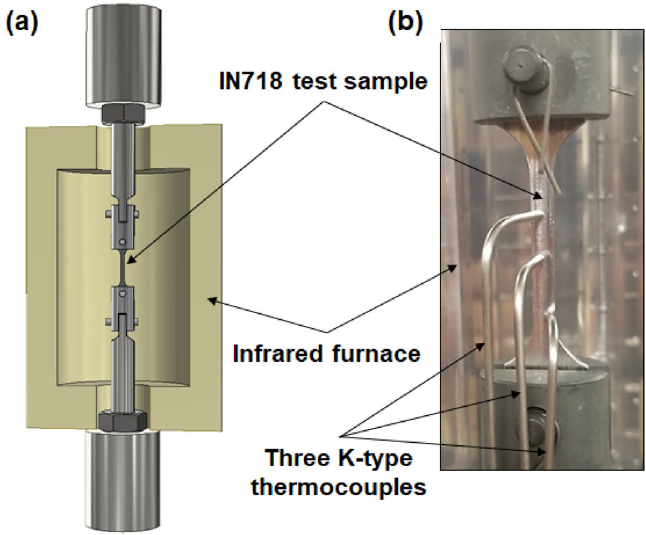
Figure 3. ( a ) Schematic illustration of the high-temperature (650 °C) tensile testing setup; ( b ) actual IN718 test sample with thermocouple